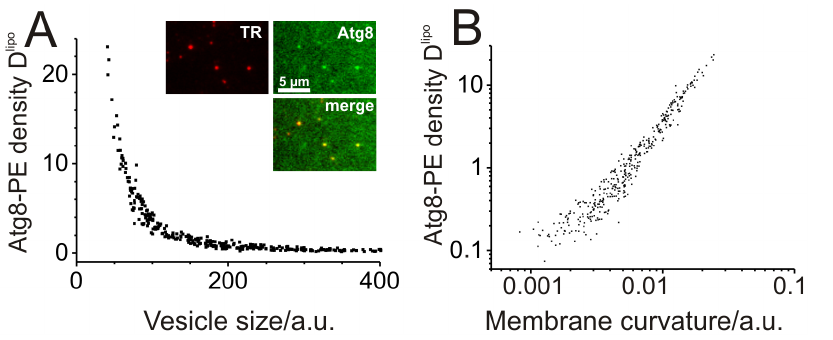
Fig. 4. Curvature preference of the Atg8 conjugation reaction. ( A ) Conjugation of Atg8 to individual liposomes of varying size as measured by the SLiC-assay [25]. The Atg8-PE density, I lipo q ffiffiffiffiffiffiffiffi , after 20 min incubation with 125 nM Atg8 for n 5 366 vesicles. The a function of the vesicle radius, I lipo TR insets show snapshots of immobilized liposomes. ( B ) Atg8-PE density (same data) as a function of membrane (cid:4) ffiffiffiffiffiffiffiffi q curvature, 1 I lipo TR